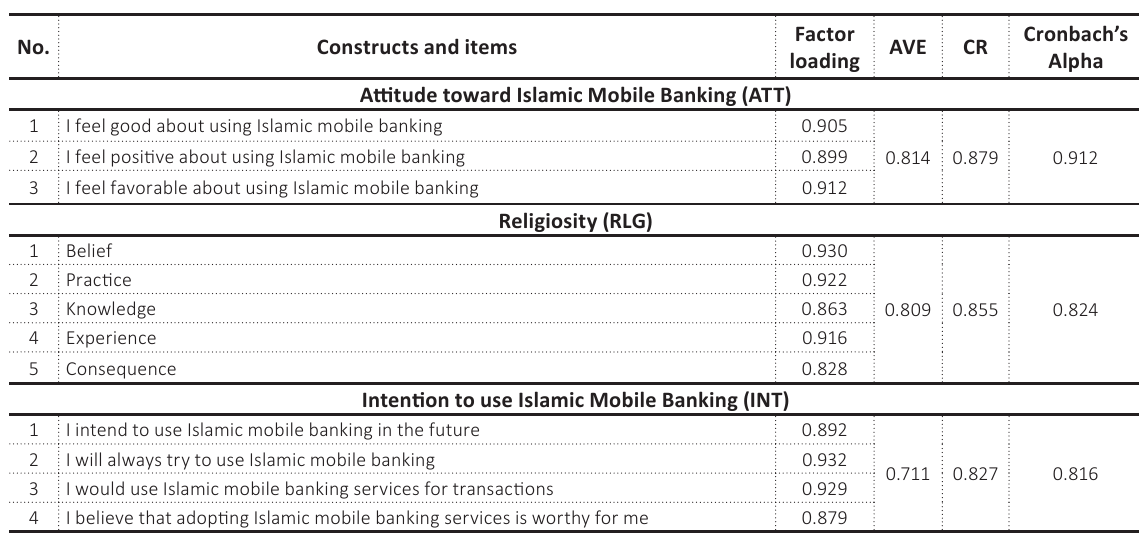
Table 1 (cont.). Validity and